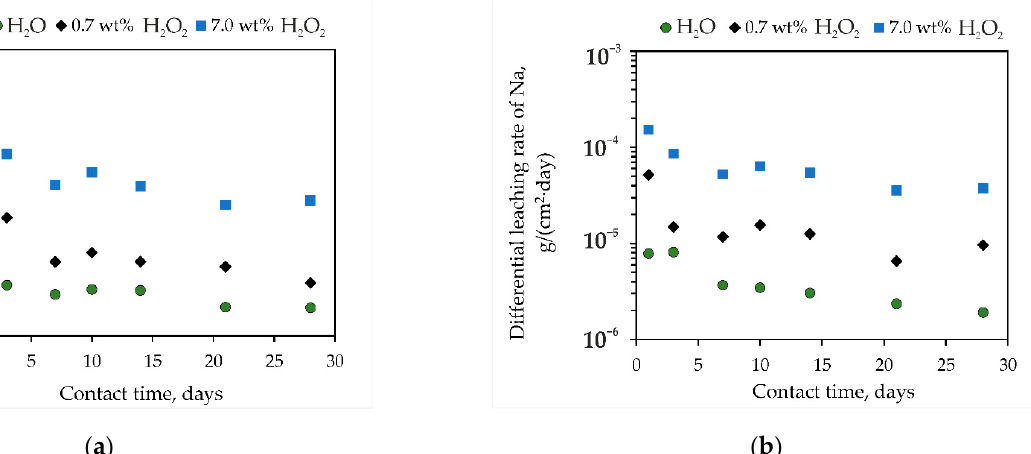
Figure 1. Kinetic curves of the leaching rate of Na from ( a ) initial samples of NAFP glass and ( b ) samples after heat treatment at 450 °C.